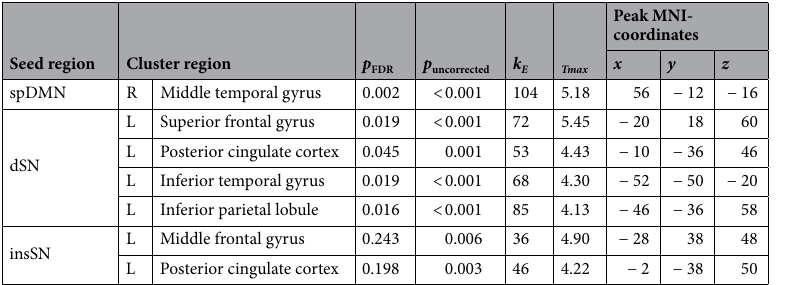
Table 3. ANOVA results and peak activations of clusters with associated anatomic regions. k E Number of voxels in cluster, T max Maximum value of T-statistic in cluster, spDMN superior posterior default mode network, dSN dorsal salience network, insSN insular salience network, R Right hemispheric, L Left